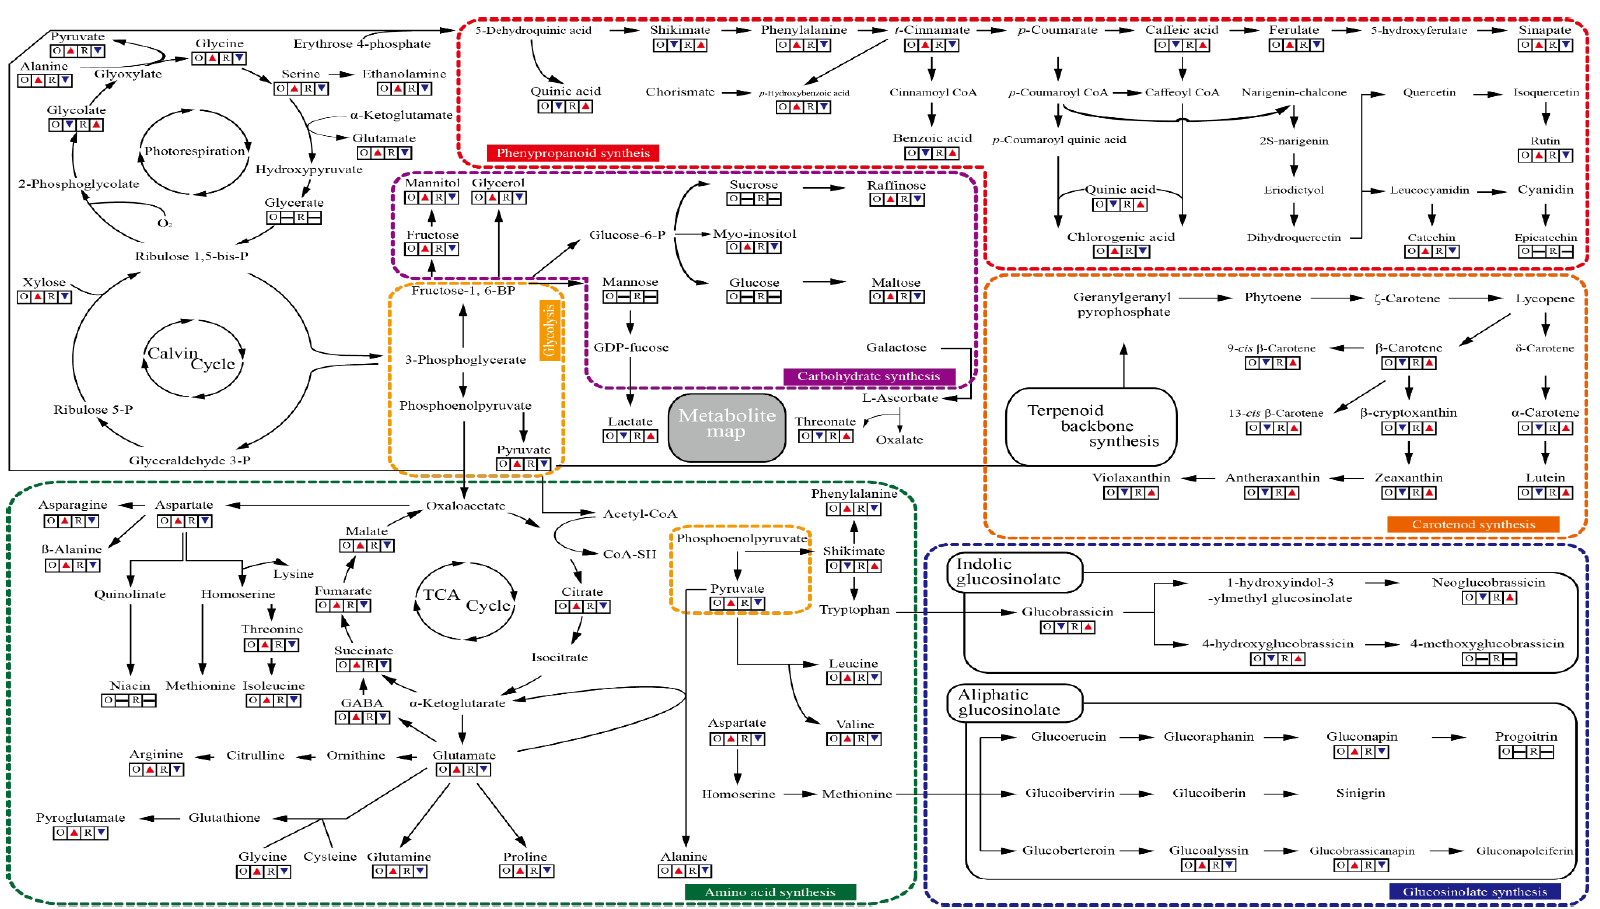
Figure 2. A metabolite map comparing primary and secondary metabolites of the oval and rectangular Chinese cabbage cultivars. The up arrow ( ▲ ) indicates that the mean value of the target metabolite is significantly higher (at p < 0.05). The down arrow ( ▼ ) indicates that the value of the metabolite is significantly lower (at p < 0.05). The horizontal bar ( – ) means that mean values of the target compounds were not significantly different (at p < 0.05). A different letter (O and R) indicated oval Chinese cabbage (B. rapa subsp. pekinensis cv. Asia Spring) and rectangular Chinese cabbage (Chinese cabbage. B . rapa subsp. pekinensis cv. Miss Jin).